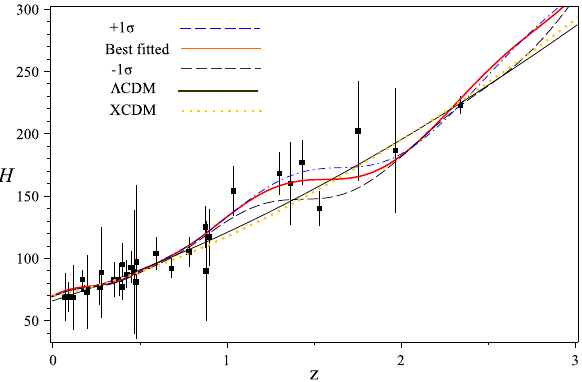
Fig. 5 The plot of parameters H for the best-fitted, upper line with + 1 σ and a lower line with − 1 σ values of (α,β) and initial conditions in chameleon model and redshift range 0 . 07 < z < 2 . 36